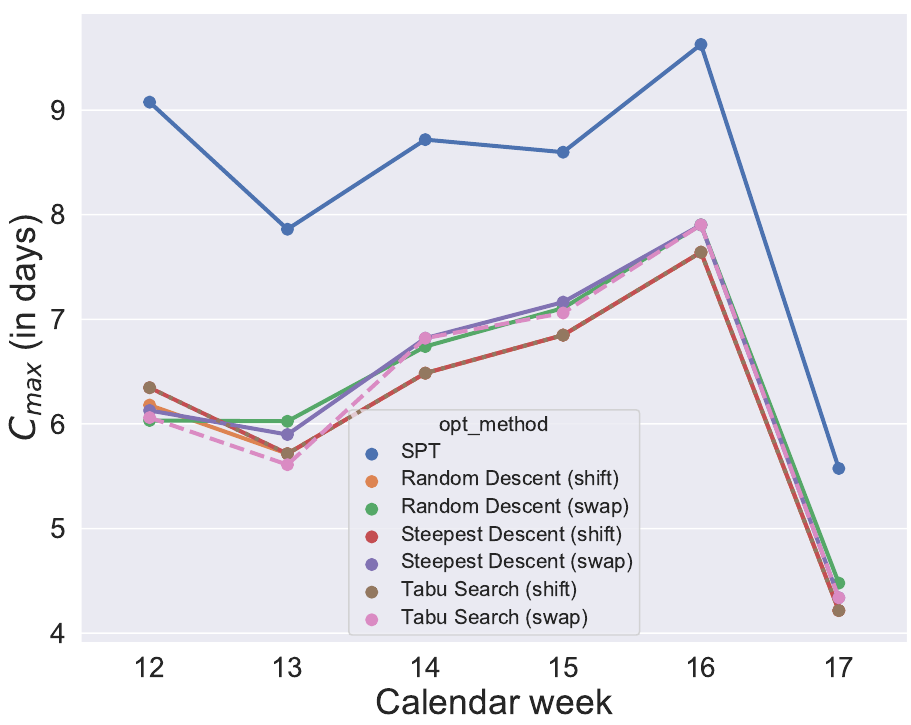
Figure 11. Optimization results for quantile